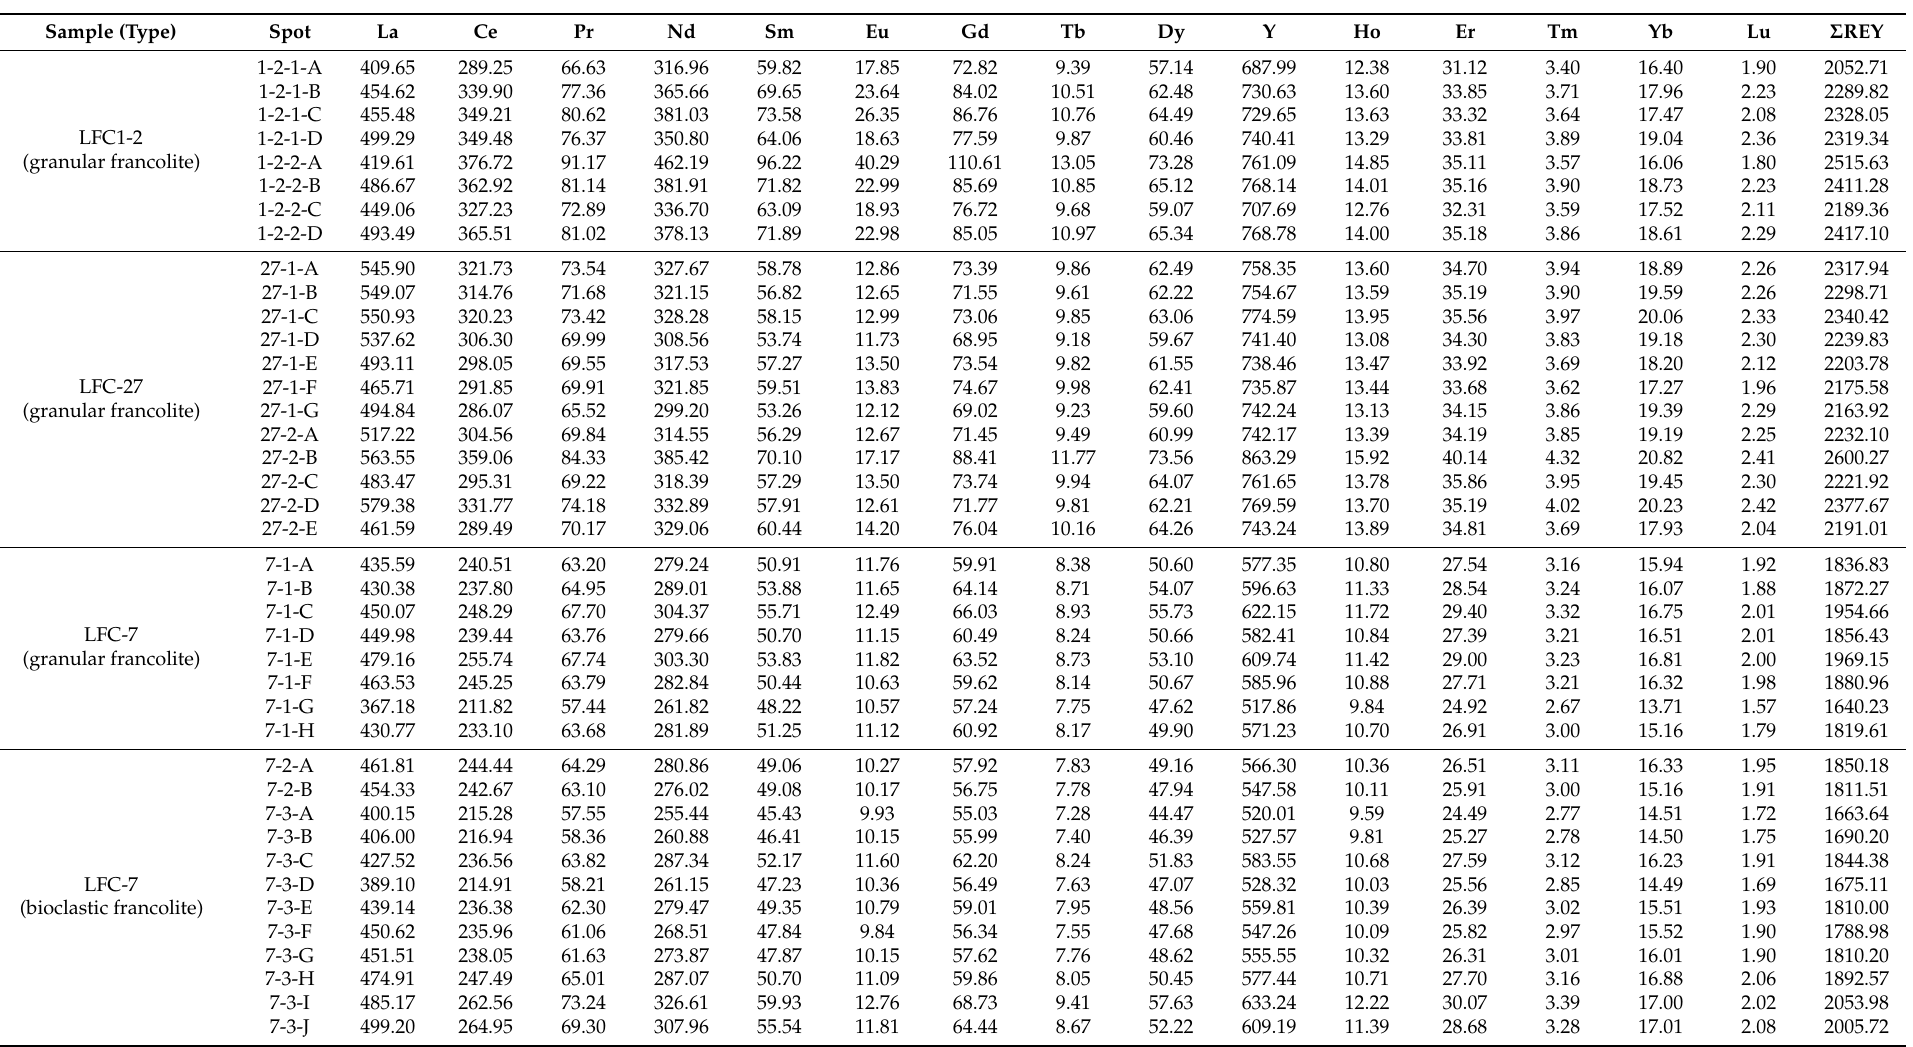
Table 3. In situ Σ REY of the francolite and dolomite from the LFC section